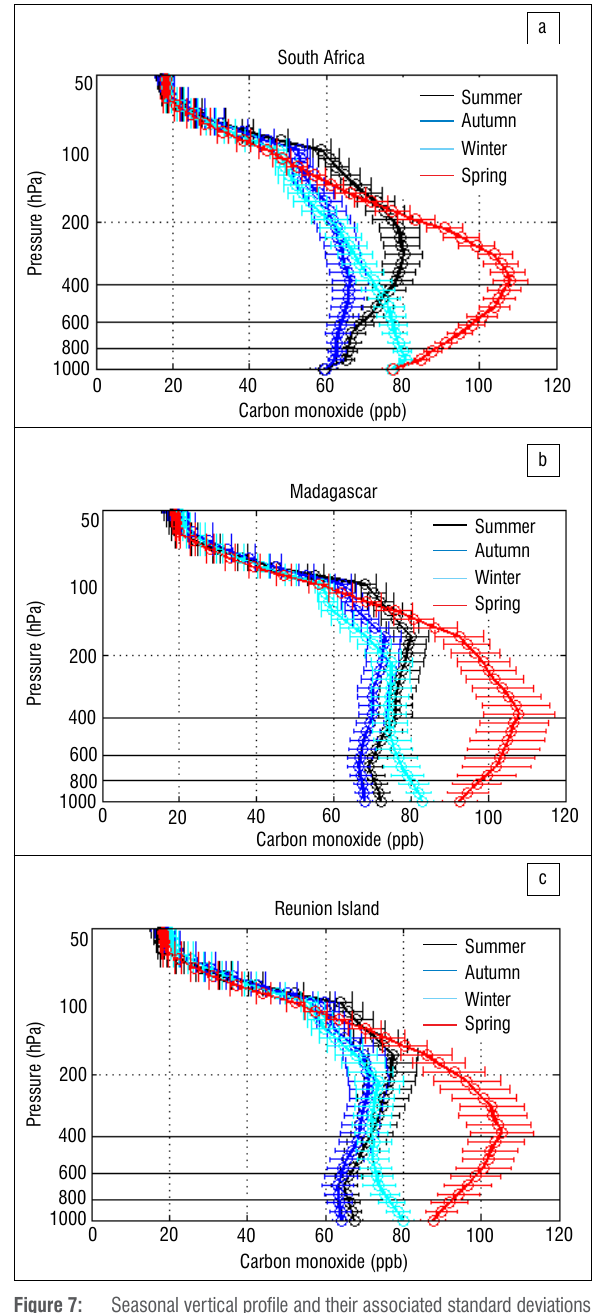
Figure 7: Seasonal vertical profile and their associated standard deviations for each pressure level over (a) South Africa, (b) Madagascar and (c) Reunion